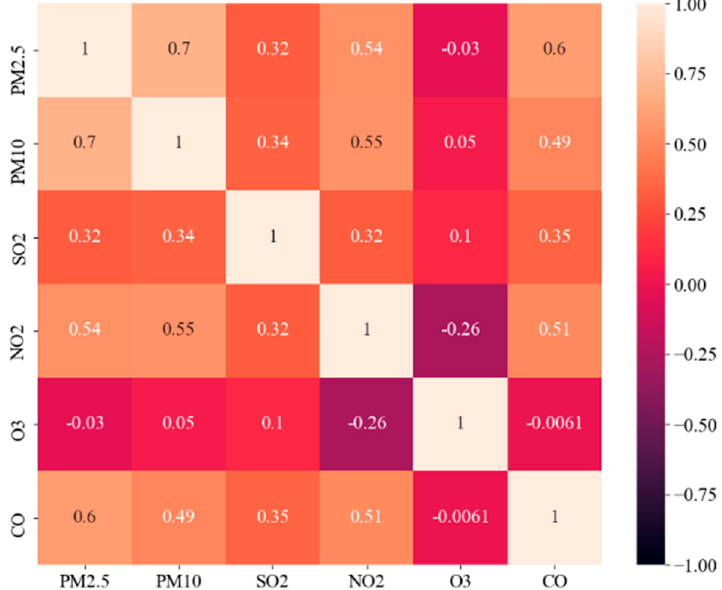
Figure 3. Map of the correlation coefficient between the PM 2.5 concentration value and all other pollutant parameters.